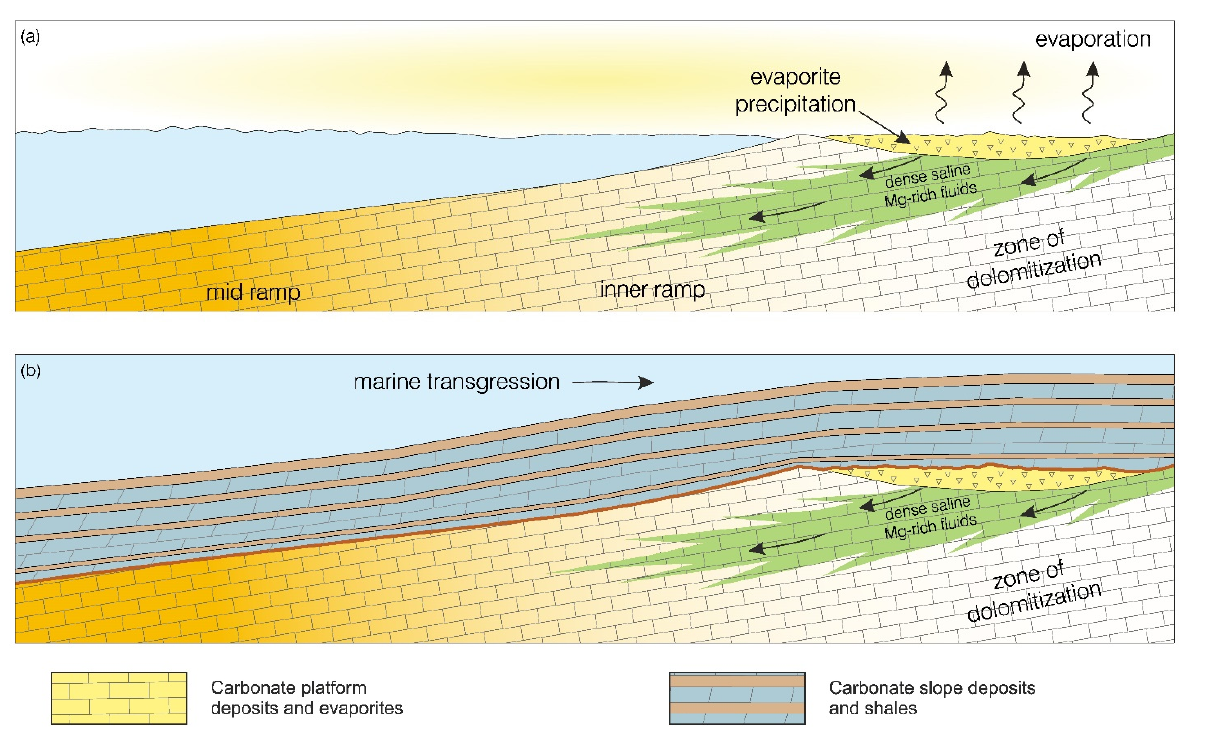
Figure 10. Stratigraphic evolution of the Mârmorilik Formation from ( a ) evaporite-carbonate platform facies to ( b ) carbonate slope facies and shales.